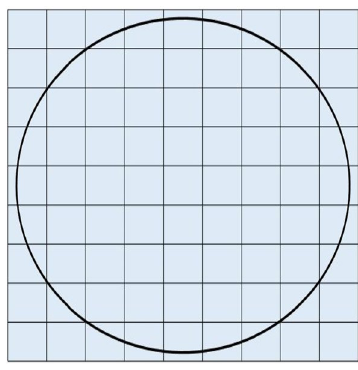
Fig. 19 Finite element mesh used in the analysis and unfitted boundary